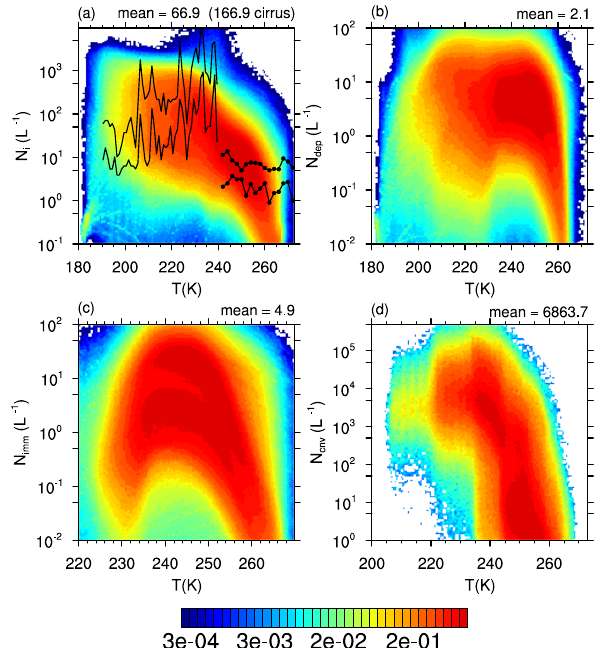
Figure 6. Global frequency of in-cloud ice crystal number concen- tration as a function of temperature from 6h instantaneous GEOS-5 output over a 3-year subset (2002–2004) of the NEW run. (a) Ice crystal concentration, N i . Solid lines represent the 25 and 75% quantiles from the field campaign data analysis of Krämer et al. (2009). Solid-dotted lines represent the typical range of mean N i found in mixed-phase clouds (Gultepe and Isaac, 1996). (b) Ice crystal concentration from deposition/condensation ice nucleation, N dep . (c) Ice crystal concentration from immersion ice nucleation, N imm . (d) Ice crystal concentration from convective cumulus de- trainment, N cnv